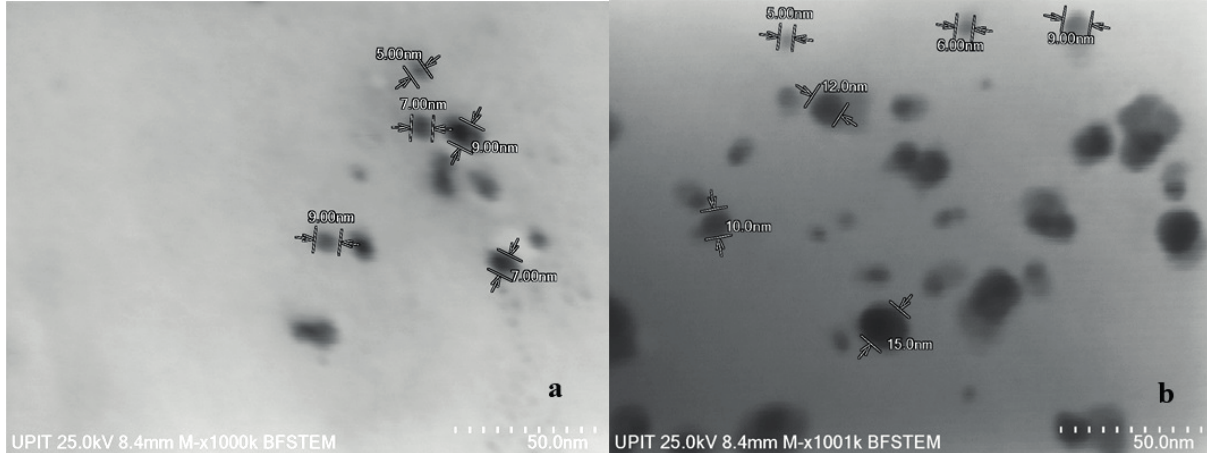
Figure 7. Dispersion dimensional analysis of AgClNPs for M_UAE_10_70_AgCl (a) and for S_M_70_AgCl (b) in BFSTEM at 1,000,000 (x1000k) magnification.